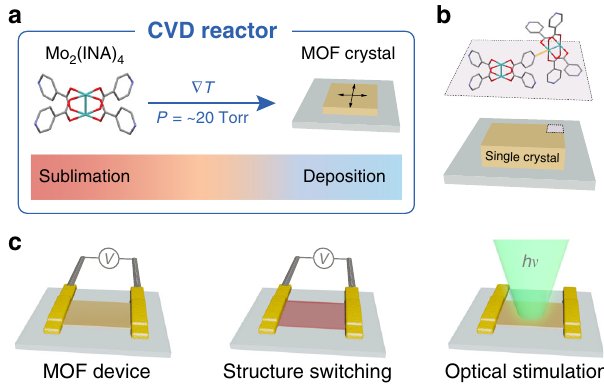
Fig. 1 Gas-phase synthesis of large-area MOF crystals and their integration into devices. a Schematic outlining the process for CVD growth of high-quality MOF single crystals with minimal defects and single-crystal character. A MOF precursor, such as Mo 2 (INA) 4 , sublimes under vacuum, is swept by a carrier gas along a thermal gradient, and deposits at lower temperatures to form high-quality MOF single crystals on a range of substrates. b Concerted deposition and coordination of Mo 2 (INA) 4 clusters leads to single MOF crystals covering large areas of the substrate. c The large-area single crystals are integrated into devices (left), which are used to monitor the electronic response of the MOF to induced structural changes (middle) and to optical stimulation